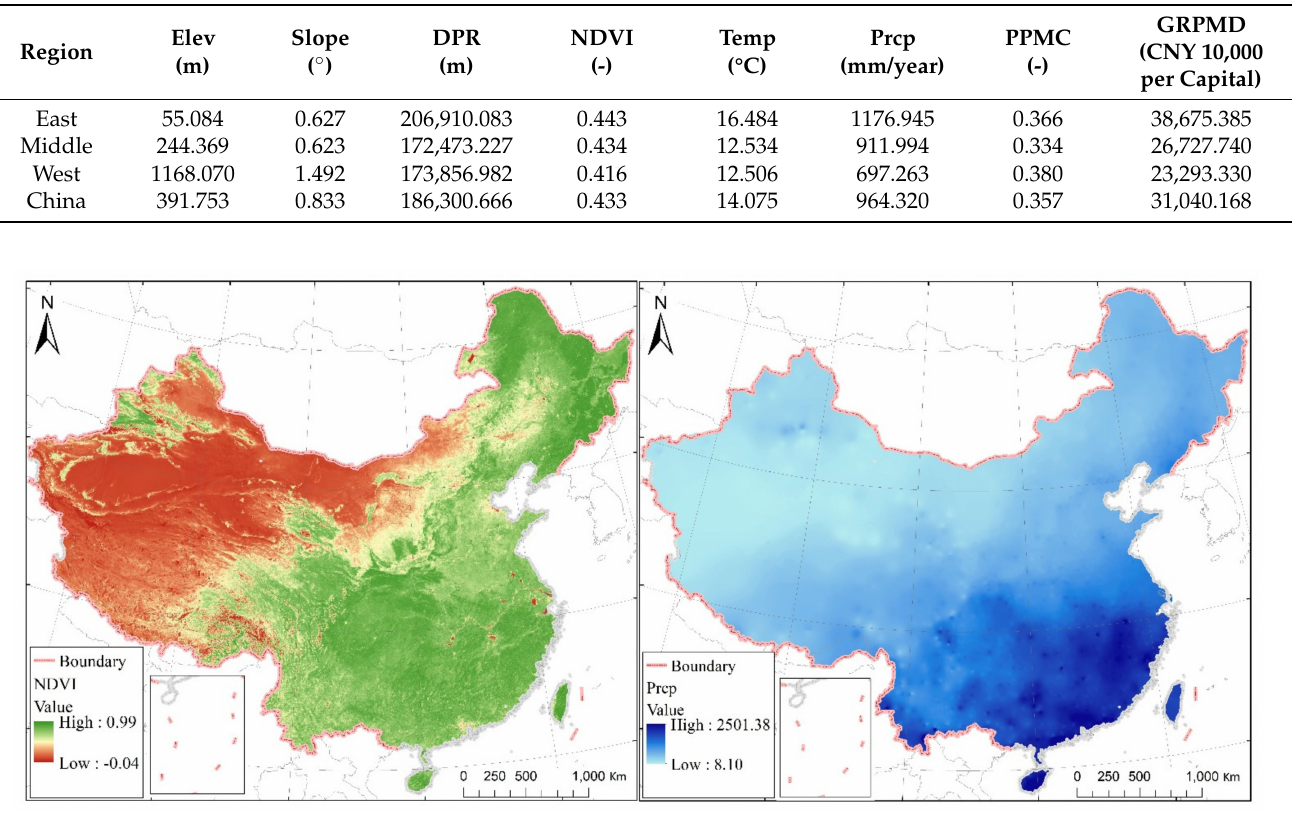
Table 7. Natural and economic features in China’s eastern, middle, and western regions (see Table 1 for acronyms).